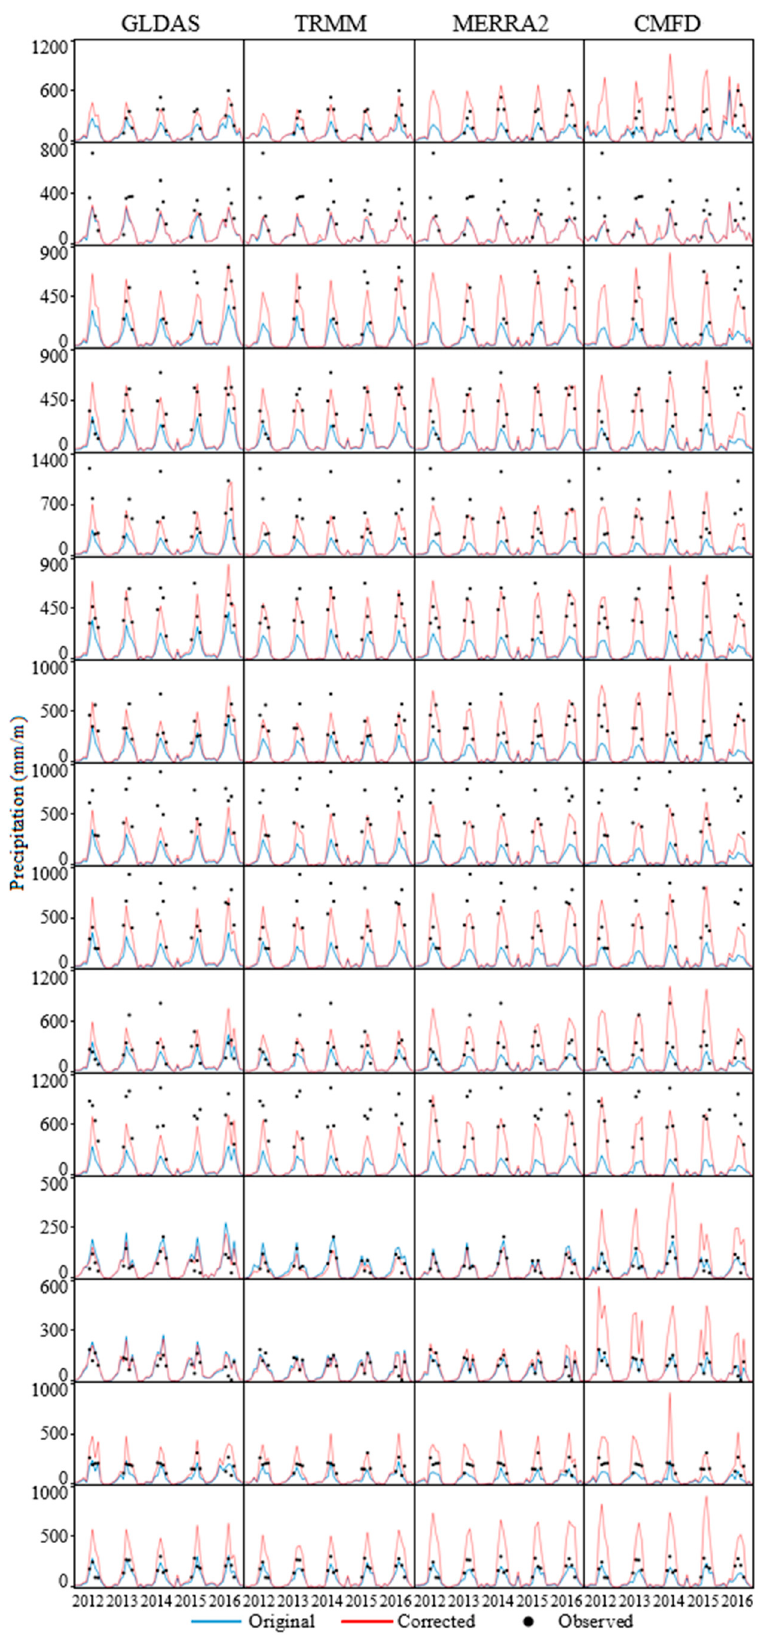
Figure 7. Comparison of original and corrected monthly precipitation at 15 stations of four products.